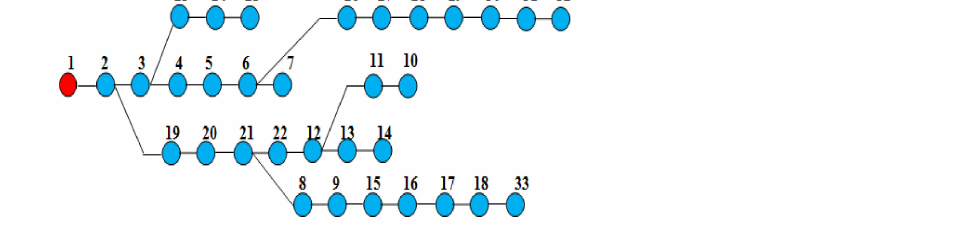
Figure 10. Optimal configuration for the minimization of the active power losses criterion (open branches: